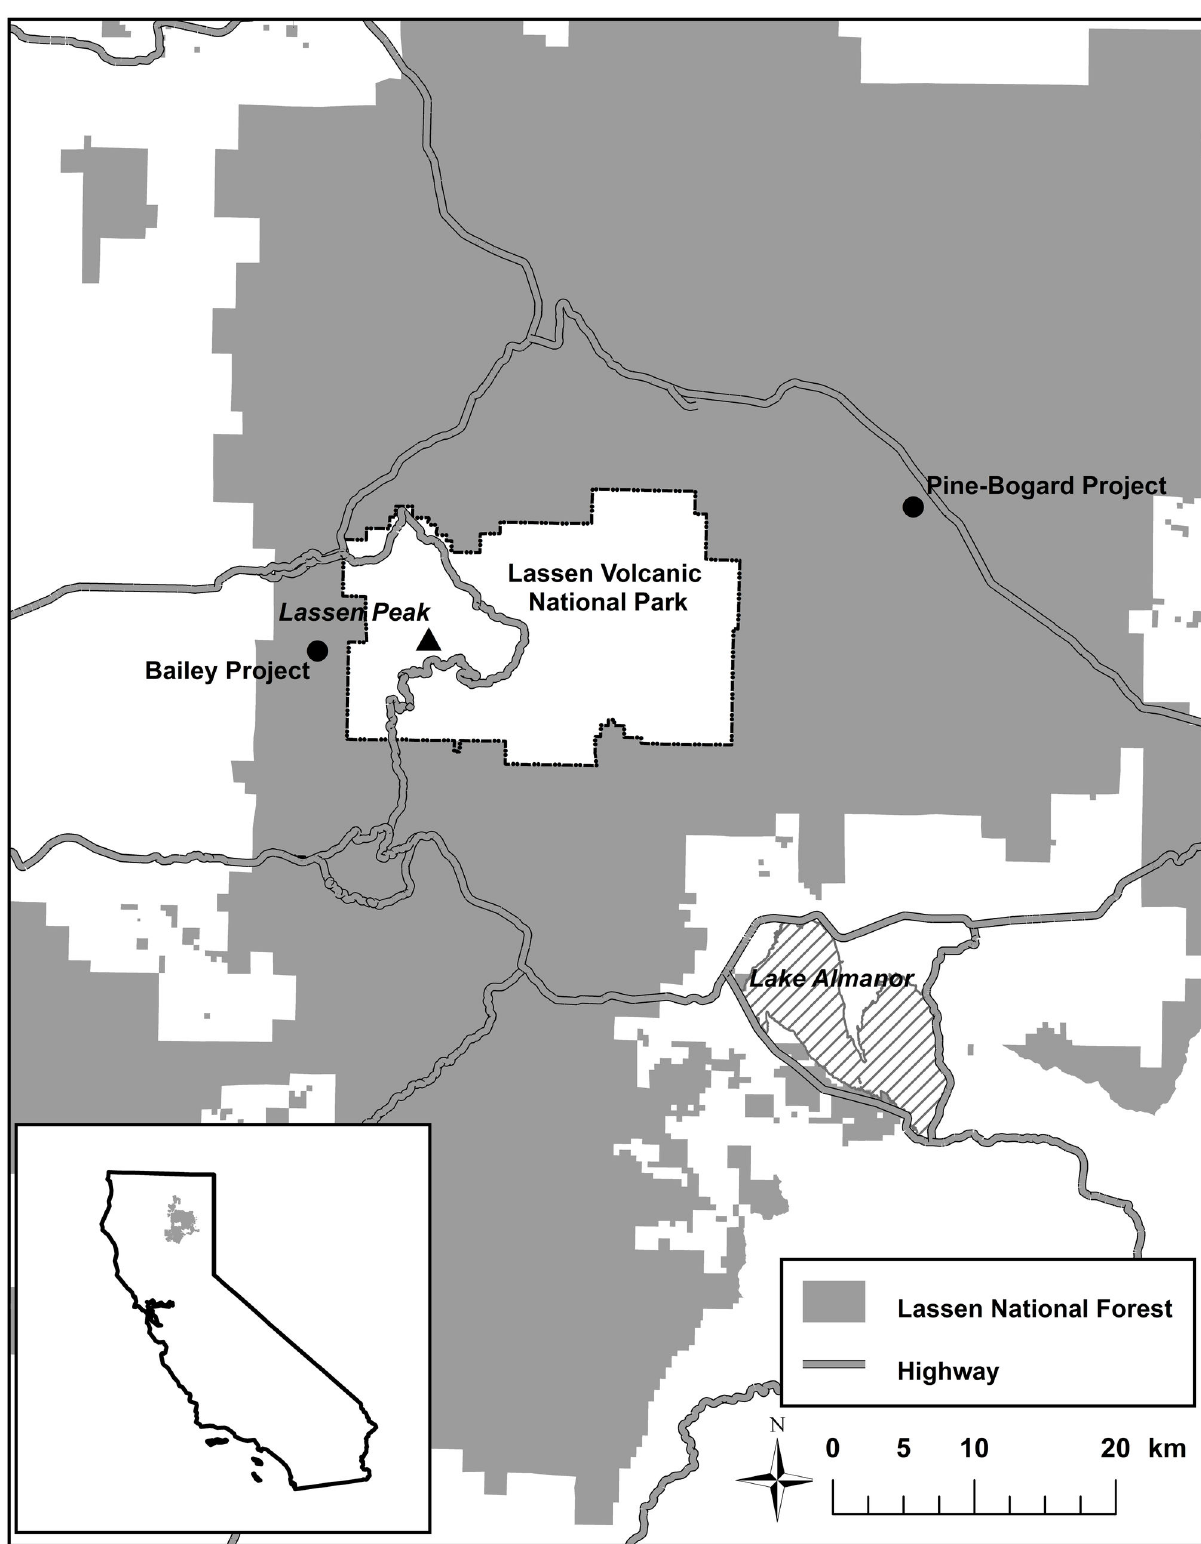
Figure 1. Pine-Bogard Project and Bailey Project